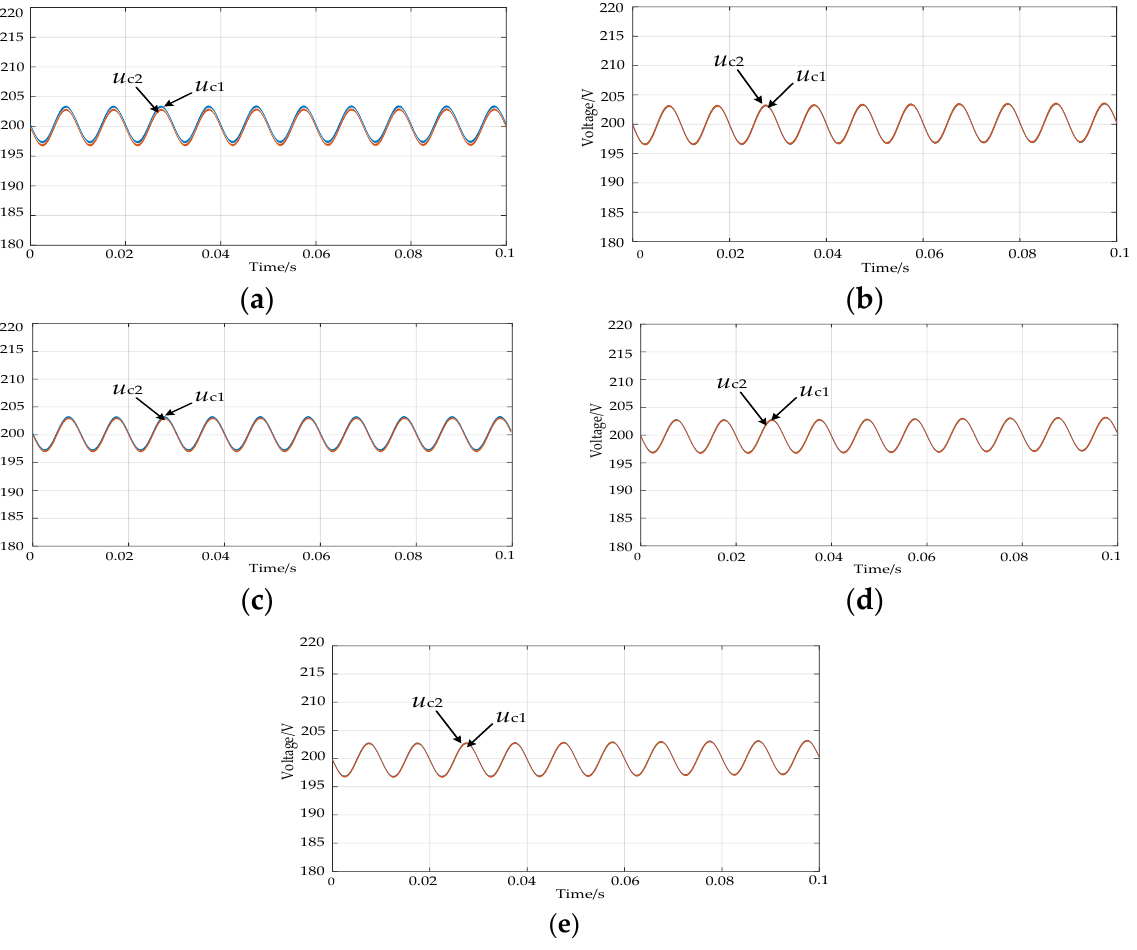
Figure 8. The voltages of u c1 and u c2 under different modulation methods during steady - state operation. ( a ) SPWM. ( b ) SVPWM - 1. ( c ) SVPWM - 2. ( d ) SVPWM - 3. ( e ) SVPWM - 4(hybrid).